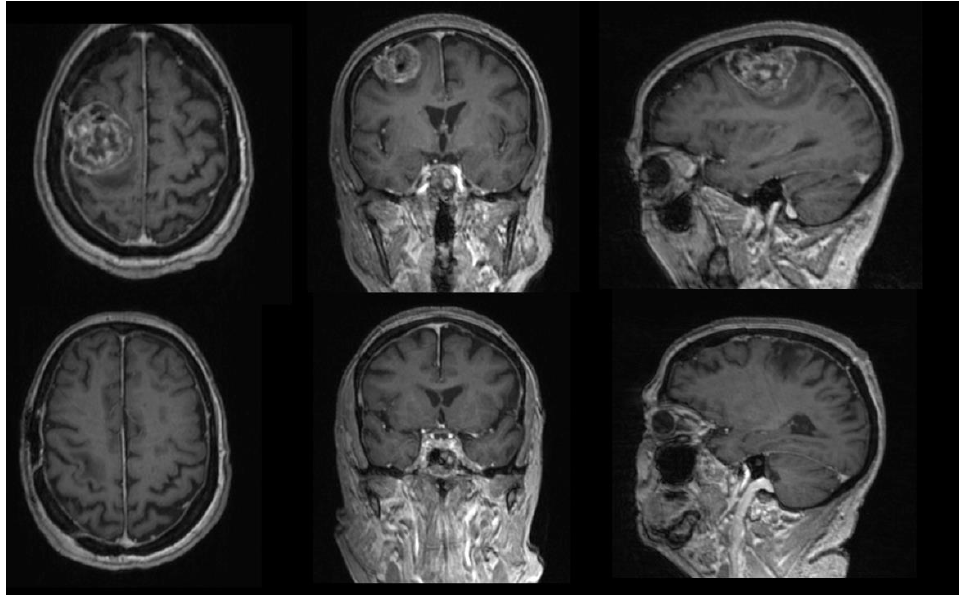
Figure 9. Images show the presence of a surgically treated right frontal parasagittal meningioma in an 80-year-old woman. Postoperative follow-up documents include a complete Simpson grade I resection; the procedure had no postoperative complications. Histologic examination confirmed the presence of grade I meningioma with progesterone negativity. The patient started experiencing seizures after 3 months. Sixteen months after the procedure, the patient died of cardiological and infectious problems.